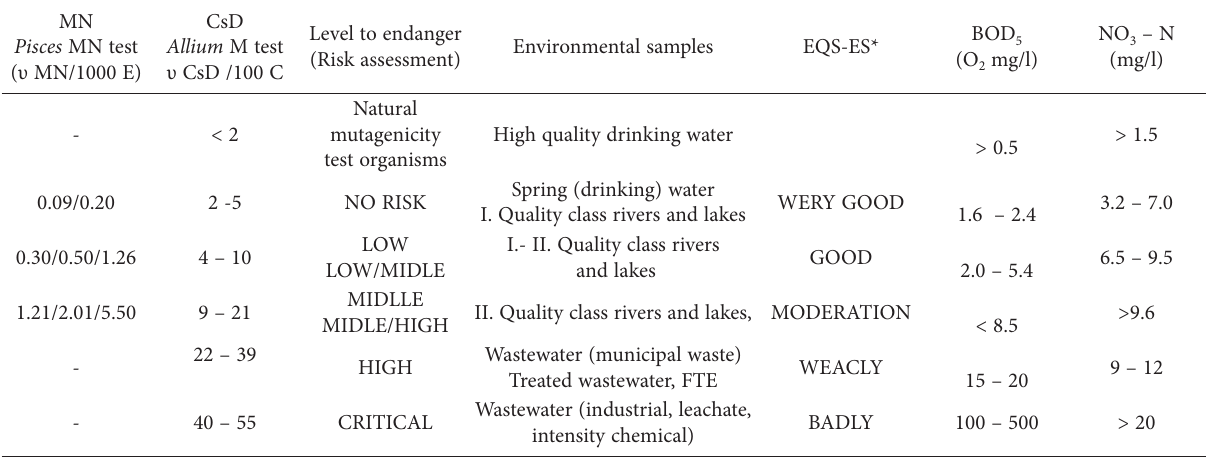
Table 7.Correlation between chromosome damage (CsD) of the Allium M test and Pisces MN test of the genotoxicitylevel (GL) with par- allel physical parameters (BOD 5 , NO 3 – N). The relationship is directly related to the Environmental Quality Standard-Ecological Status (EQS-ES) and environmental risk assessment